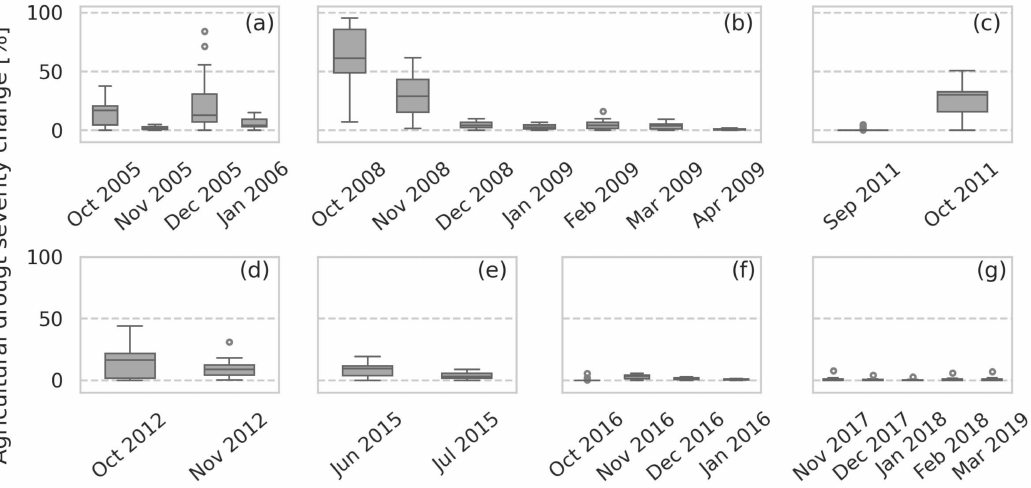
Figure 7. Agricultural drought severity changes in subbasins where RWH ponds are applied: event I ( a ), event II ( b ), event III ( c ), event IV ( d ), event V ( e ), event VI ( f ), and event VII ( g